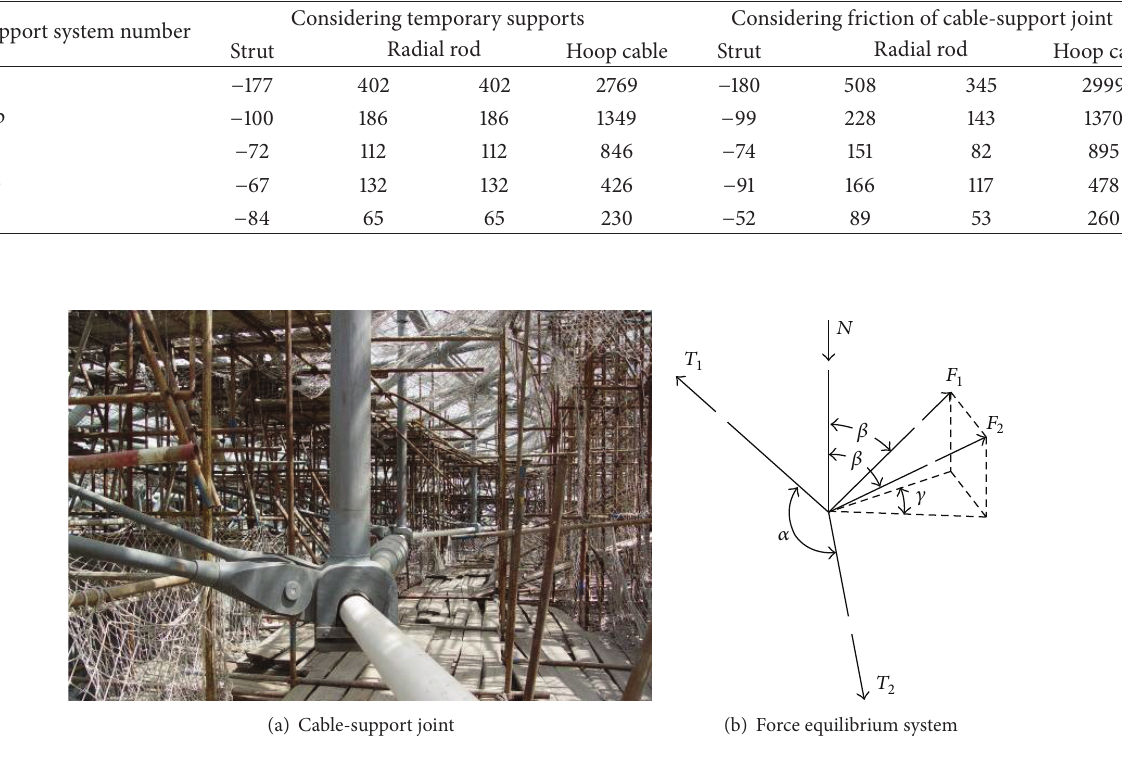
Figure 5: Sketch of the cable-support